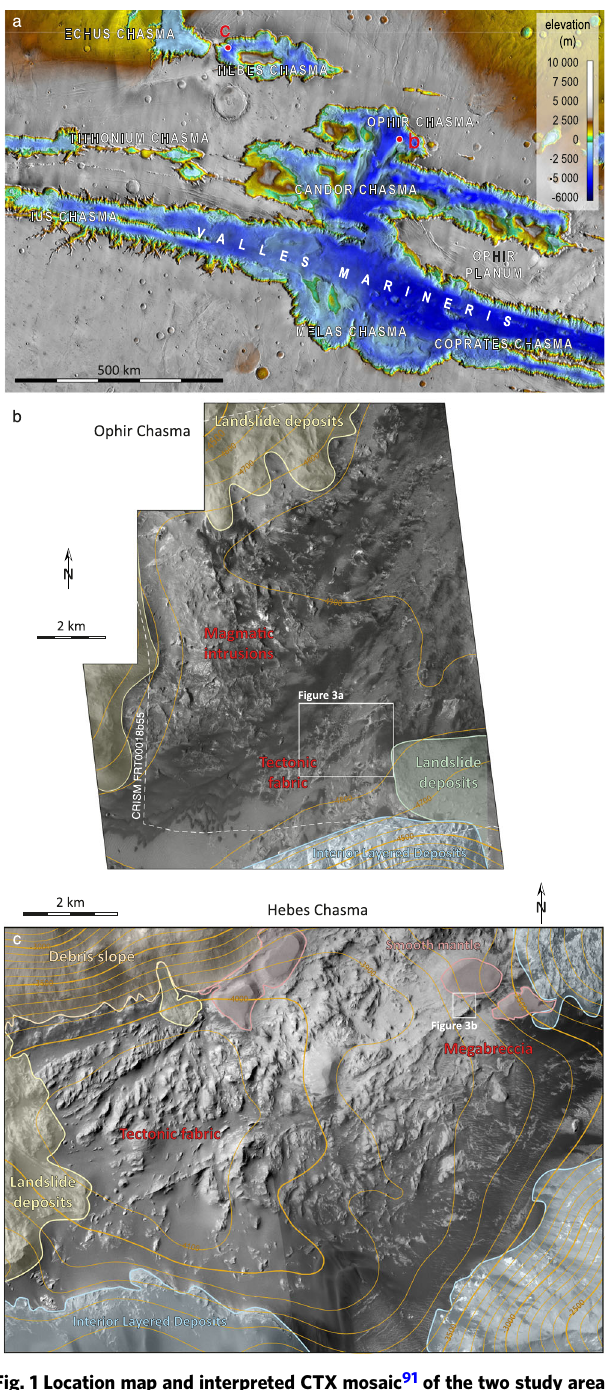
Fig. 1 Location map and interpreted CTX mosaic 91 of the two study areas in Valles Marineris. a Location map: THEMIS Day IR Global Mosaic 92 merged with the 128 ppd MOLA digital terrain model 93 . The white dashed line indicates a continuation of the Hebes tectonic fabric as a graben system onto the plateau above the chasma. b Interpreted CTX mosaic 91 of Ophir Chasma. c Interpreted CTX mosaic 91 of Hebes Chasma. The topographic information (contours, in meters) in ( b ) and ( c ) is extracted from an HRSC topographic mosaic of Valles Marineris (credit: ESA/DLR/Freie Univ.